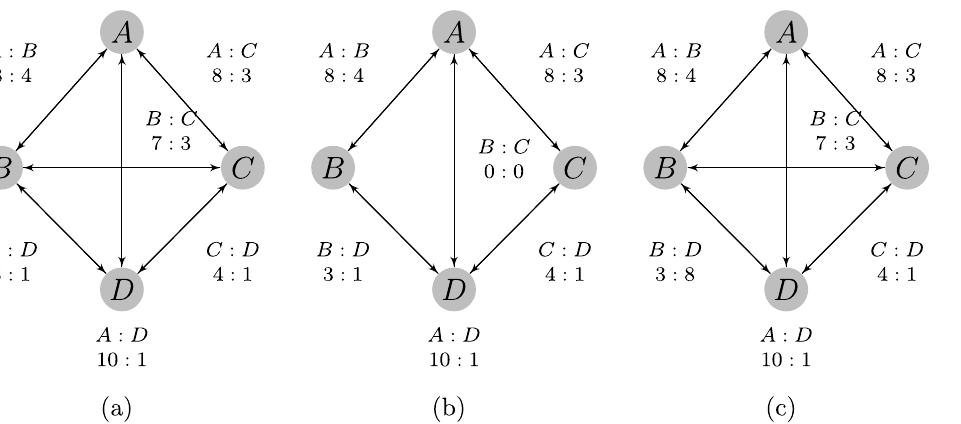
Fig. 2. Examples of three basic data structures. Example (a) is an ideal case where the data suggests a linear ordering. Despite missing information on the relationship between B and C , Example (b) is still appropriate for the Bradley-Terry model. Example (c) has a cycle producing an estimate that does not match the structure of the data.